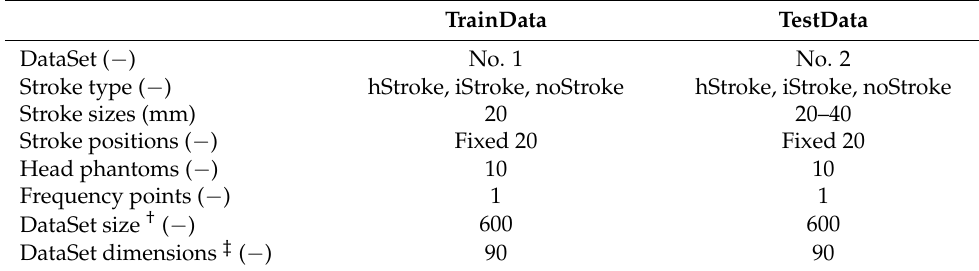
Table 5. Training and testing data parameters for hypothesis